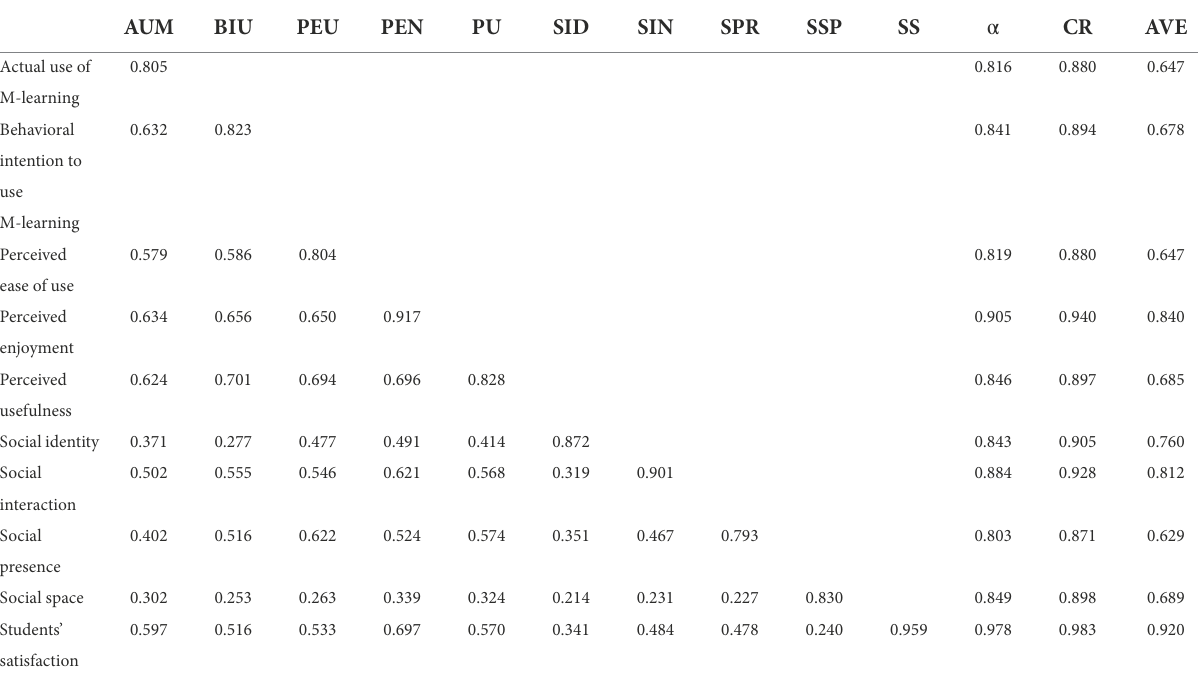
TABLE 2 Validity and reliability, α , CR, and